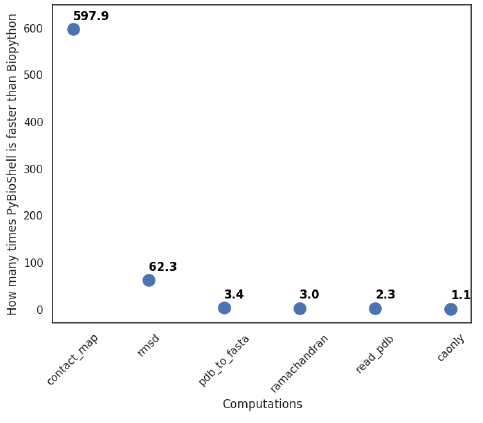
Figure 3. Results of PyBioShell and Biopython